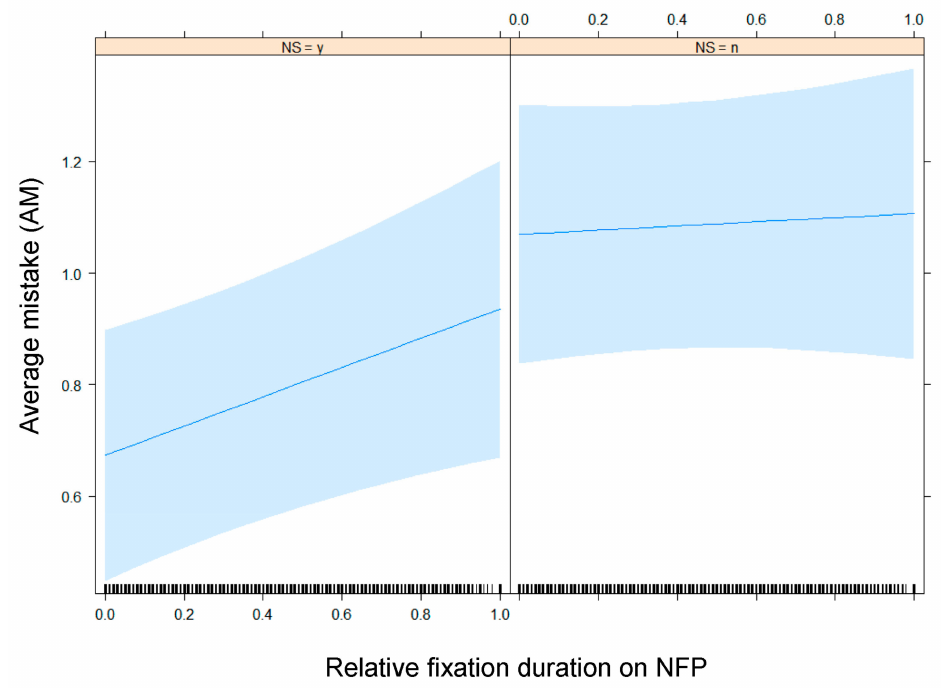
Figure 13. Impact of relative fixation duration on NFP on AM in the presence (NS = y or yes (1)) or absence (NS = n or no (0)) of the Nutri-Score label, in the subset of participants exposed to products with NFP.